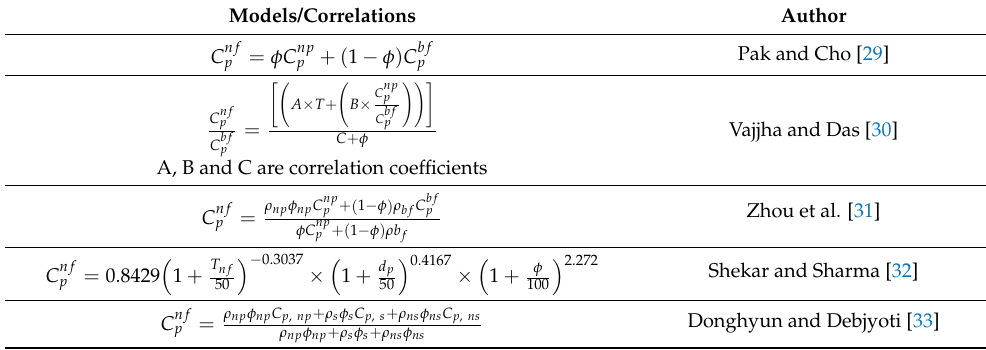
Table 1. Specific heat capacity estimation of metal oxide-based nanofluids (model and correlations).